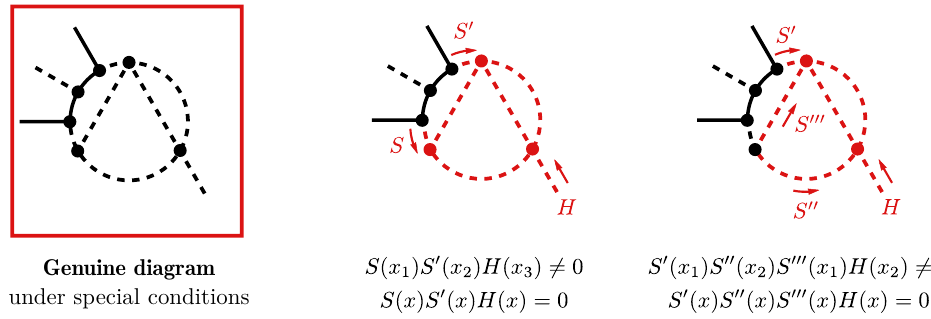
Figure 17 . Topology 71 has one genuine diagram, shown here. The quantum numbers of the scalars must be special, otherwise one could build the Weinberg operator from a 1- or 2-loop diagram. In particular, this scenario is avoided only if S = (cid:30) S (cid:17) ( 1 ; 1 ; (cid:0) 1), S 0 = H , S 00 = (cid:30) y (cid:17) ( 1 ; 1 ; y ),